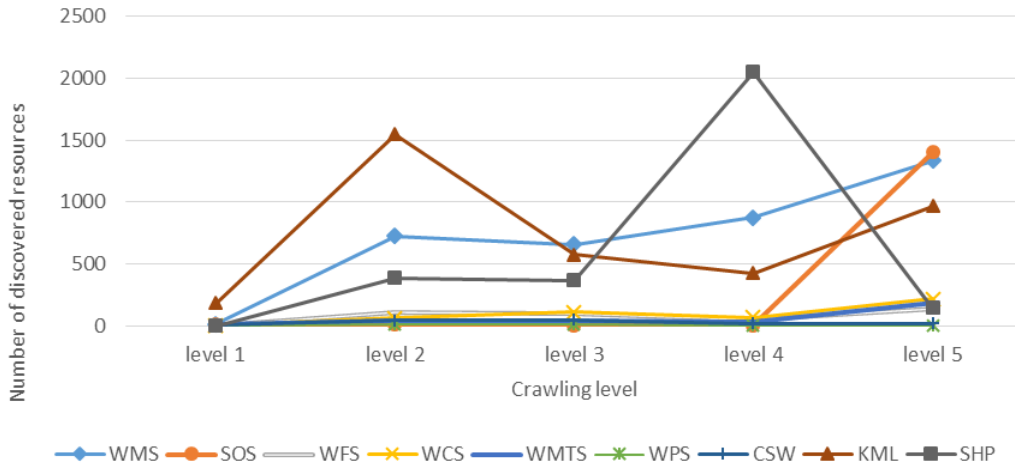
ISPRS Int. J. Geo-Inf. 2016 , 5 , 136 Figure 10. The number of discovered resources in different crawling levels. Figure 10. The number of discovered resources in different crawling levels.